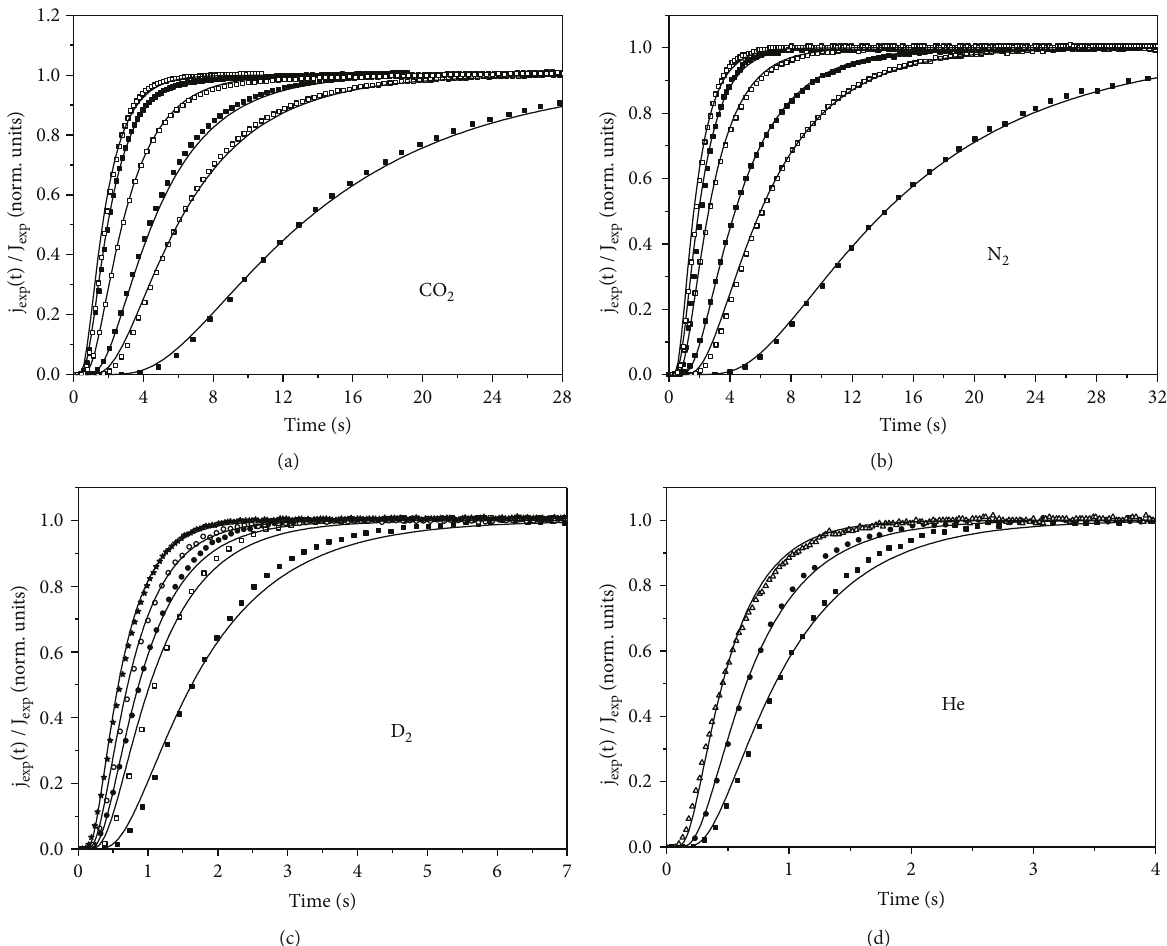
Figure 5: (a) Experimental j curves (symbols) pertinent to CO obtained at temperatures between T = 295 K and T = 351 K with t / J exp 2 exp = 40 kPa. Lines are fi tting of the experimental curves; see text. (b) Experimental j curves (symbols) pertinent to N obtained P t / J HPS exp 2 exp = 40 kPa. Lines are fi tting of the experimental curves; see text. (c) Experimental at temperatures between T = 295 K and T = 351 K with P HPS curves (symbols) pertinent to D obtained at temperatures between T = 295 K and T = 345 K with P = 40 kPa. Lines are t / J j exp HPS 2 exp fi tting of the experimental curves; see text. (d) Experimental j curves (symbols) pertinent to He. To avoid confusion, in the fi gure, t / J exp exp we only report curves obtained at 295, 330, and 351K with P = 40 kPa. Lines are fi tting of the experimental curves; see HPS